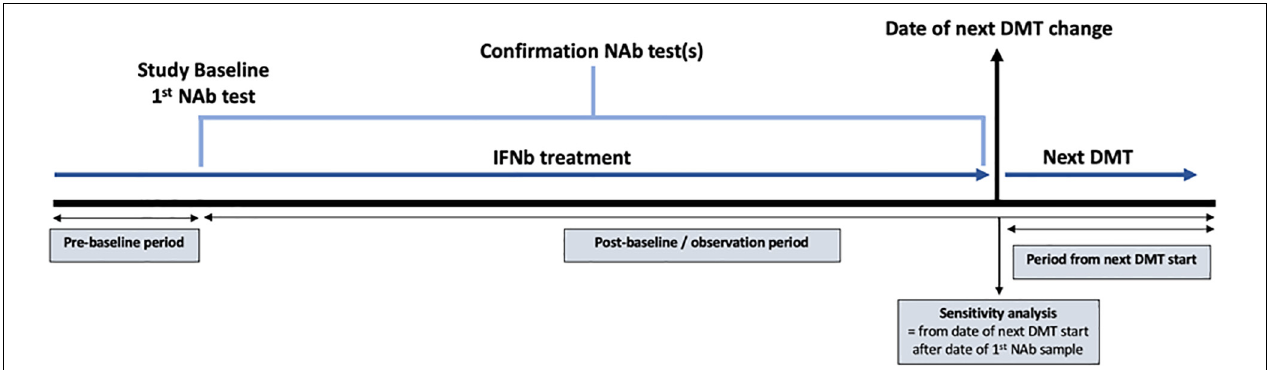
FIGURE 1 | Diagram demonstrating the study design using data extracted from the Swedish Multiple Sclerosis registry. The study baseline was defined as the date of the first recorded high titer for the high titer group and the date of the first recorded negative titer for the persistent negative group. NAb = neutralizing antibody; IFN β = interferon beta; DMT = disease modifying